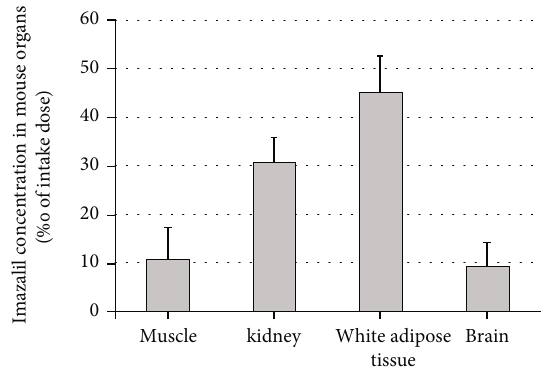
Figure 1: Imazalil accumulated in analyzed organs of Swiss albino mice (pooled samples of 8 mice, 4male + 4females ). The columns represent mean values ( ‰ ) of imazalil in the muscle, kidney, white adipose tissue, and brain of Swiss albino mice after 28-day imazalil exposure. The wishers represent the standard deviation of the mean of triplicate analysis of a pooled